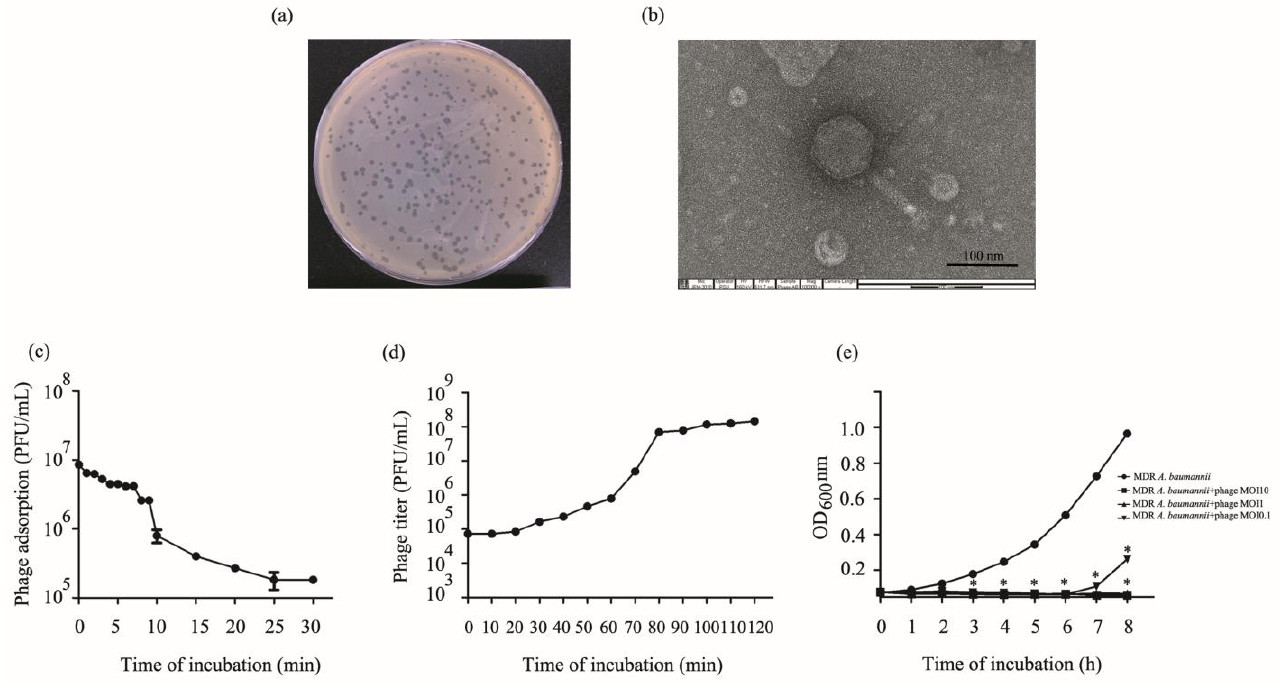
Figure 1. Isolation and biological characterization of phage vABPW7. ( a ) Plaques of phage vABPW7 in an MDR A . baumannii lawn. ( b ) Transmission electron micrograph of phage vABPW7. ( c ) Adsorption rate of phage vABPW7 to the host bacterial strain. ( d ) One-step growth curve showing the latent period and burst size of phage vABPW7. ( e ) Reduction in bacterial growth by phage vABPW7 at different MOIs. Experiments were undertaken independently in duplicate with duplicate assay. The data show the mean ± SEM (* p value <